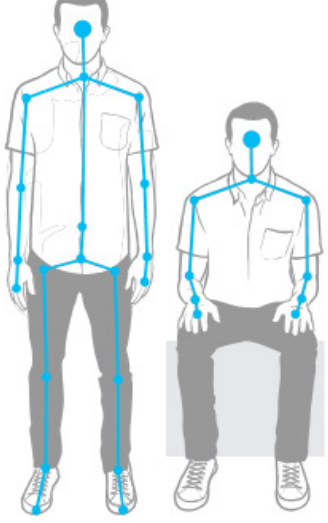
Figure 3. Standing vs. sitting